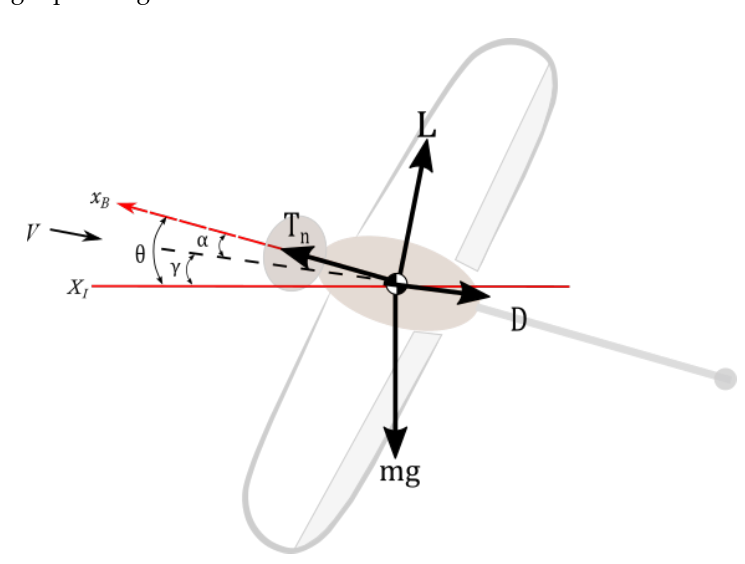
Figure 4. Forces acting on the aircraft model in